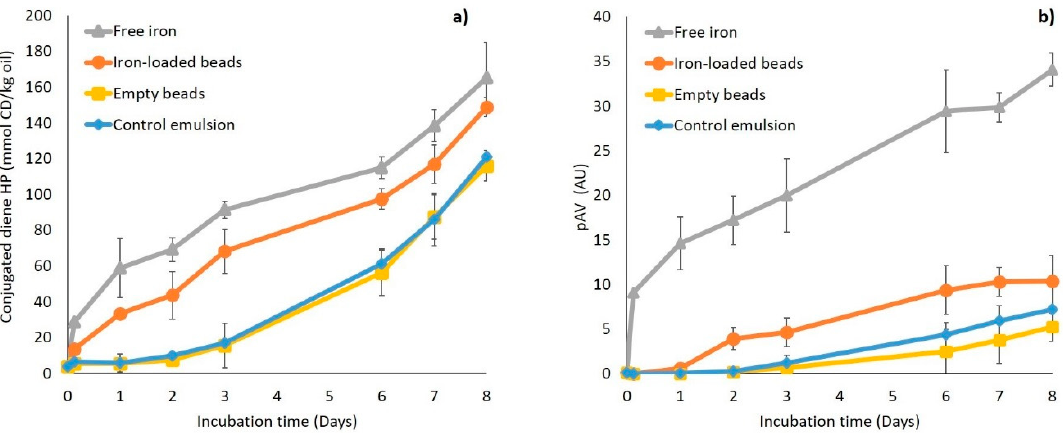
Figure 4. ( a ) Conjugated diene (CD) hydroperoxide concentrations and ( b ) para-anisidine value (pAV) in emulsions containing free iron ( ▲ ), iron-loaded alginate beads ( ● ), or empty alginate beads ( ■ ), and in the control emulsion ( ♦ ). All emulsions were incubated at 25 ° C under slow rotative agitation. For the two emulsions containing iron (FeSO 4 ), the total concentration was 200 µM. Error bars represent standard deviations ( n = 4).